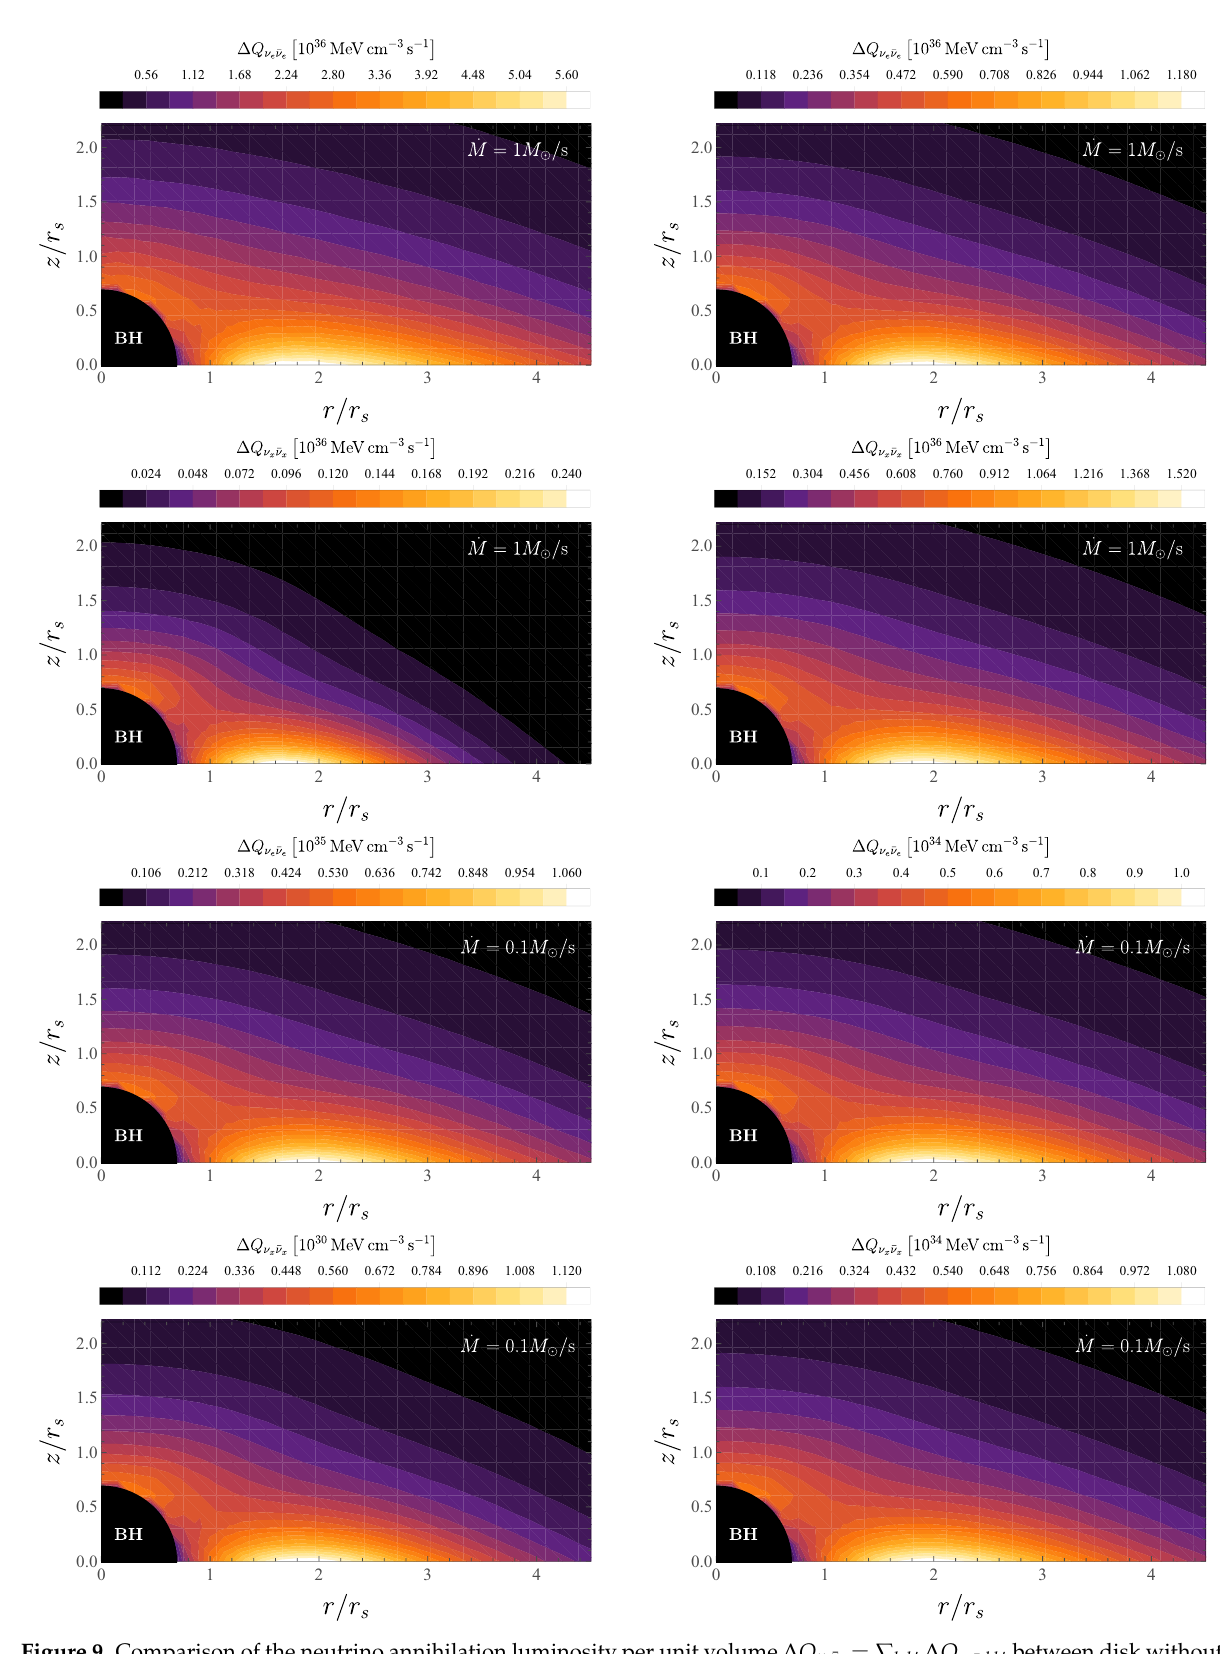
Figure 9. Comparison of the neutrino annihilation luminosity per unit volume ∆ Q ν ( left column) and with ( right column) flavor equipartitioning for accretion rates ˙ M = 1 M (cid:12) s − 1 and ˙ M = 0.01 M (cid:12) s − 1